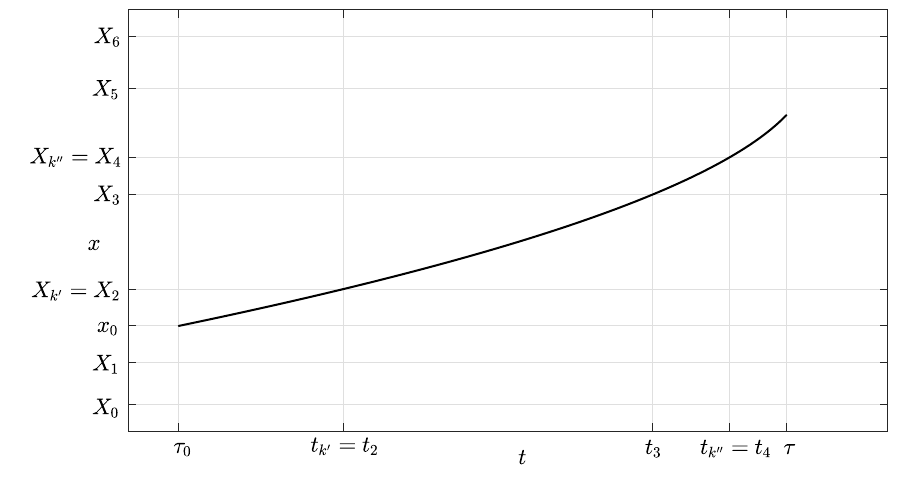
Figure A2. Example of function x ( t ) , with m = 6, k (cid:48) = 2, and k (cid:48)(cid:48) =